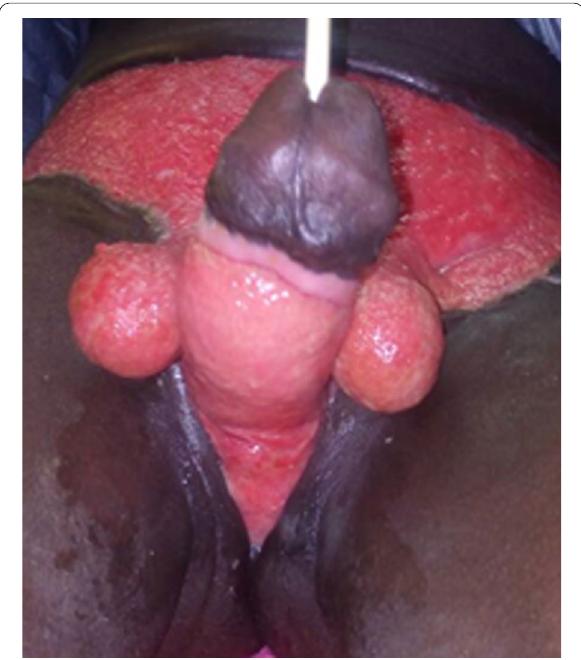
Fig. 2 Peno‑scrotal wound defect with extension to the lower anterior abdominal wall is shown in Fig. 3